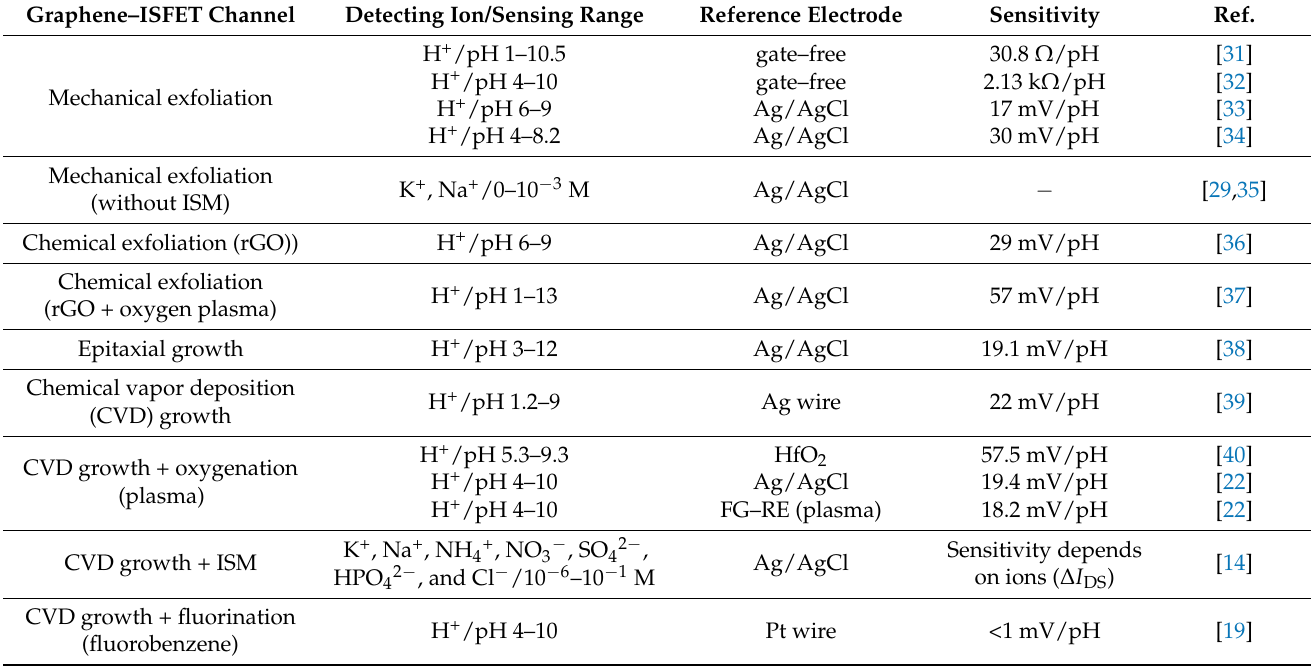
Table 2. Comparison of recent G–ISFETs to detect specific